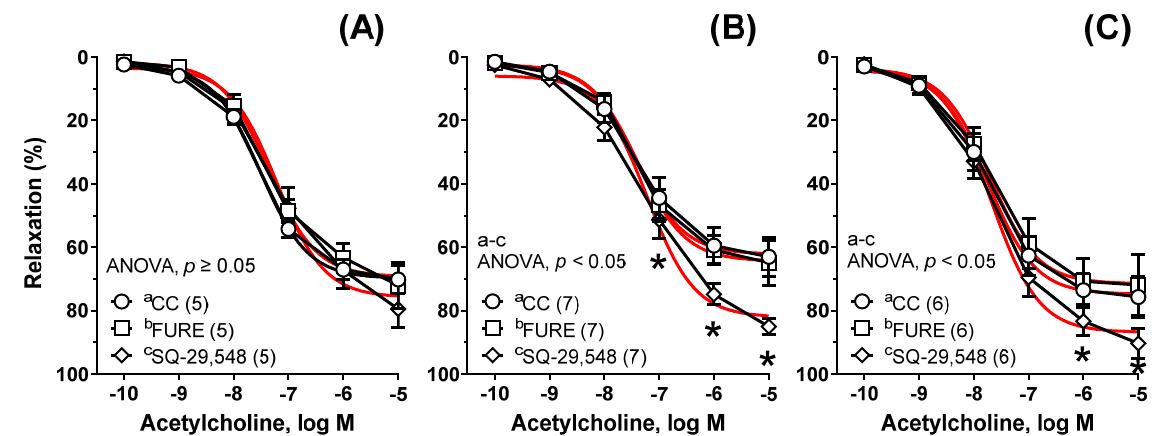
Figure 7. The influence of furegrelate and SQ-29,548 on the relaxant response to acetylcholine. Aortic rings from rats supplemented with Cu 6.5 ( A ), NP 3.25 + Cu 3.25 ( B ), and NP 6.5 ( C ) were pre-incubated with the thromboxane-A 2 synthetase inhibitor (FURE, 30 min, 1 µ M) and the thromboxane-A 2 receptor antagonist (SQ-29,548, 30 min, 1 µ M). Results are means ± SEM, * p < 0.05; ANOVA/Tukey’s. Number of animals is indicated in parenthesis. SQ-29,548 potentiated vasodilation in the NP 3.25 + Cu 3.25 and in the NP 6.5 group of rats.